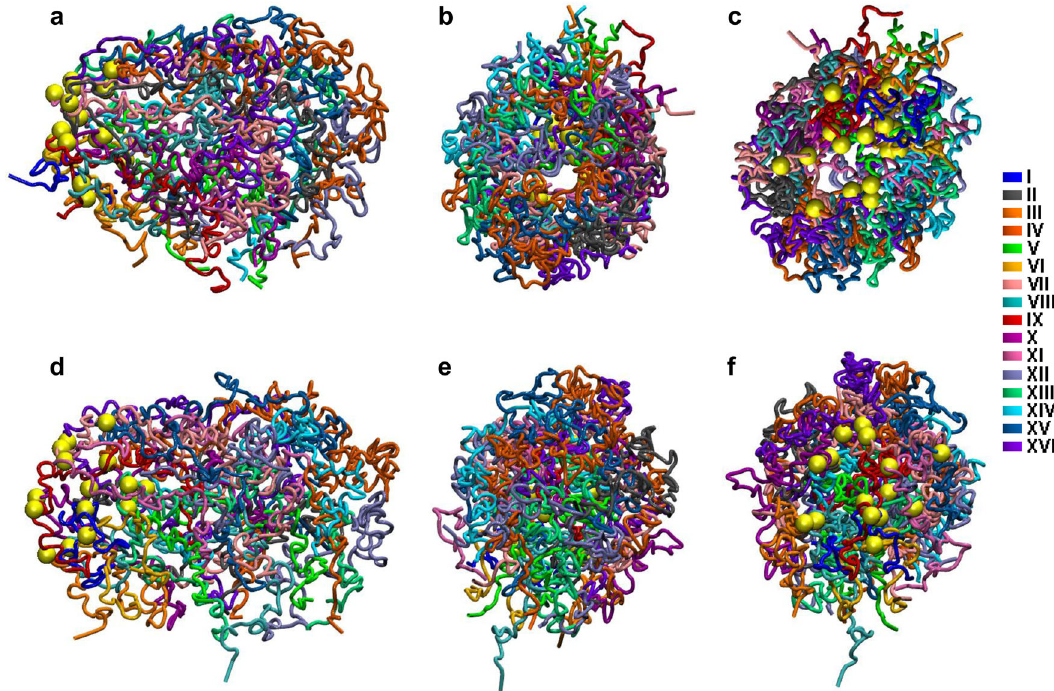
Fig. 8 Whole-genome 3D model. Three views are provided representing three different angles for ( a – c ) the control samples and ( d – f ) the methylated sample. Each chromosome is represented in a speci fi c color. Centromeres are represented in yellow. The rDNA in chromosome XII is not represented due to the lack of information provided by the Hi-C in repeated